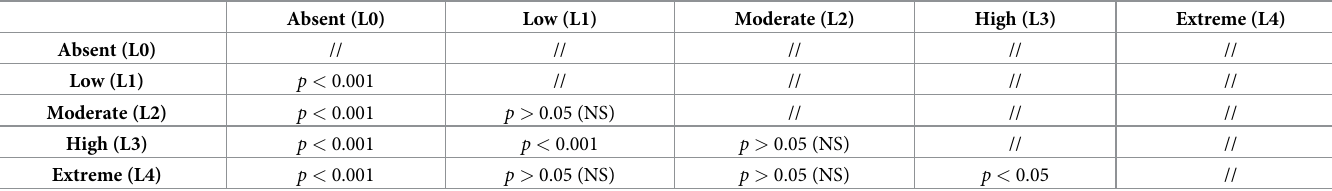
Table 1. Post-hoc comparisons (t-test with Bonferroni correction) between the performance of models with different levels of RL contribution.